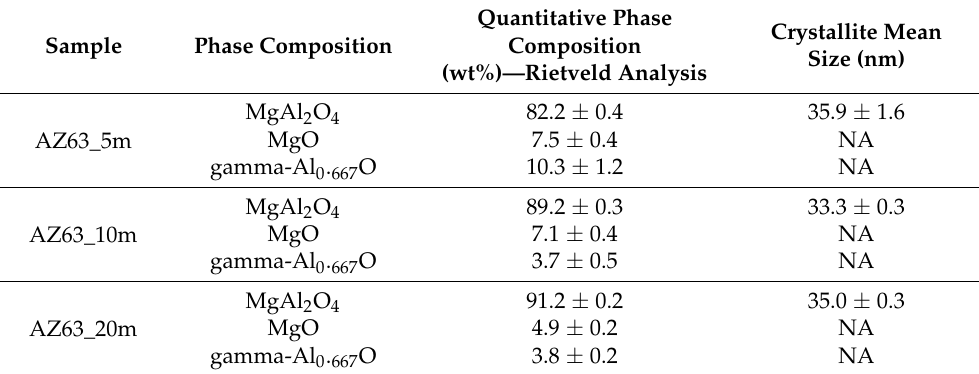
Table 6. Quantitative phase analysis and microstructural parameters of the PEO coatings detached from the substrate (in powder form).